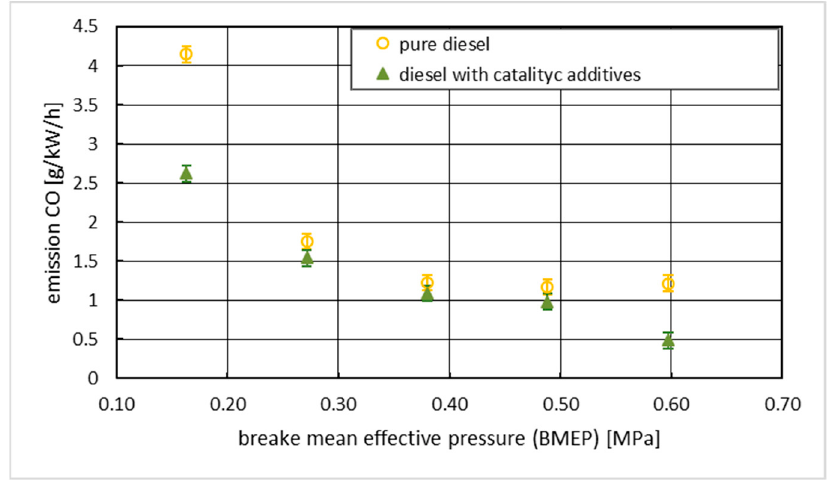
Figure 6. CO emission vs. brake mean effective pressure at an engine speed of 2000 rpm.